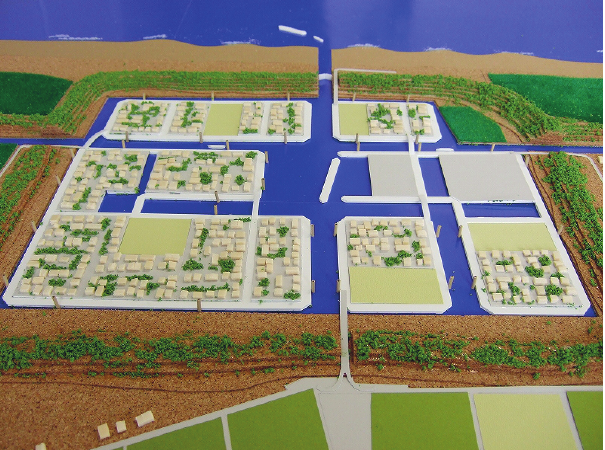
Figure 20. Bird’s-eye view of reconstructed Arahama coastal area (Image as represented by architectural model).